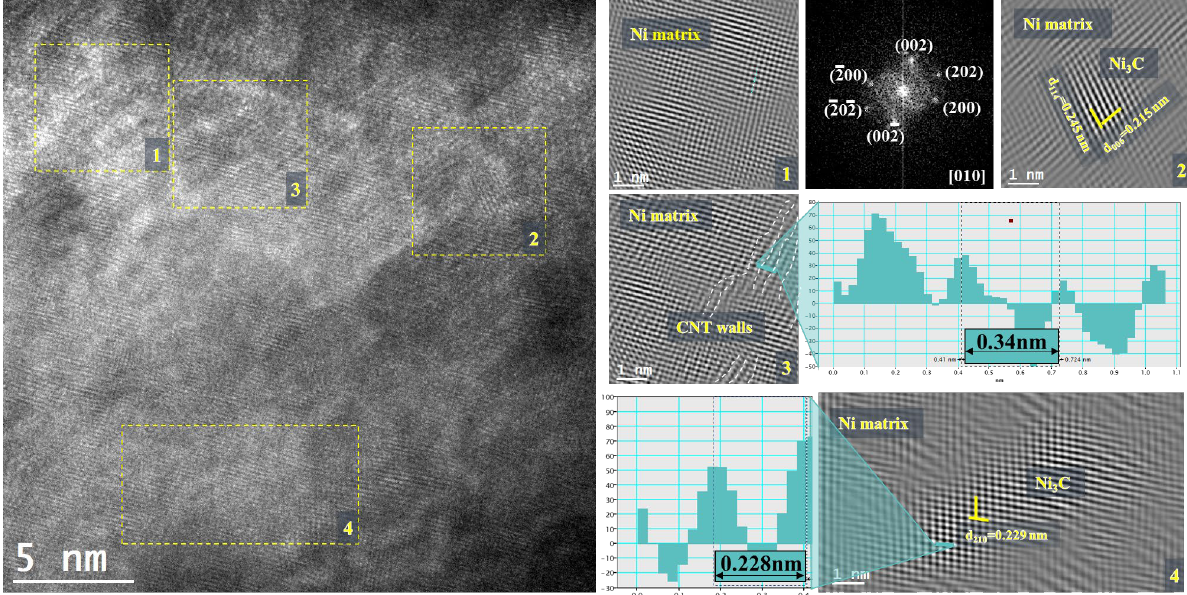
Figure 12. HRTEM image of a Ni-CNT nanocomposite heat-treated at 700 °C with different marked regions where inverse Fast Fourier Transform (FFT) was performed showing the presence of CNT and Ni 3 C phases in the matrix.